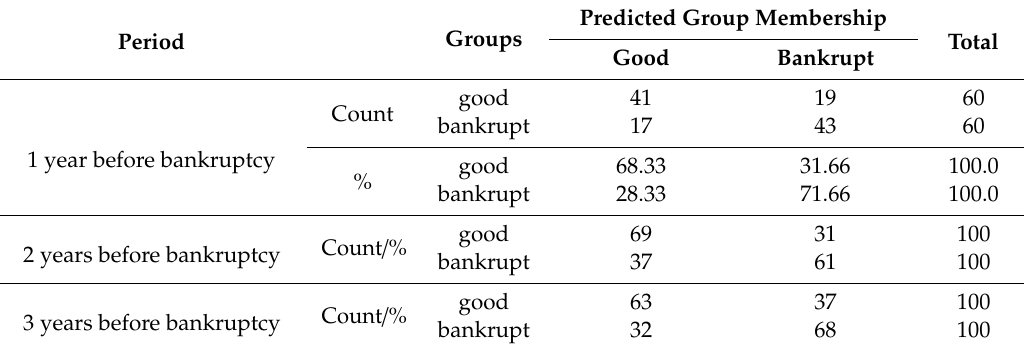
Table 9. Classification results from neural